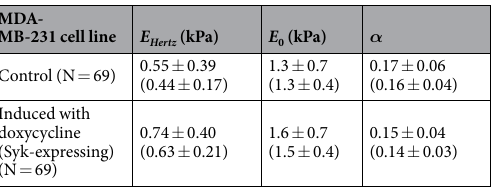
Table 2. Viscoelastic parameters of MDA-MB-231 cells without (control) and with doxycycline induction (Syk-expressing). N is the number of measured cells. Mean ± s.d. (median ± m.a.d.). All cells were at 60–80% confluence.